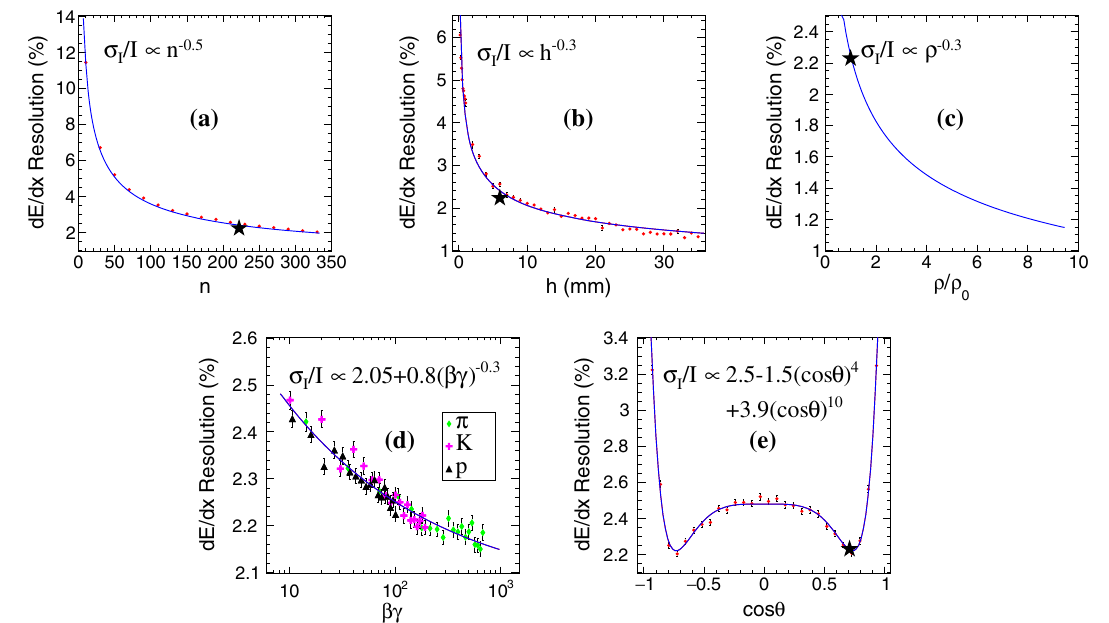
Fig. 2 The intrinsic dE / dx resolution versus the number of pad rings ing pressures) ( c ), the relativistic velocity βγ ( d ) and cos θ ( e ) of the ( a ), the pad height along the radial direction ( b ), the ratio of gas density ionizing particle. The default working point is indicated with a solid ρ over the default gas density ρ star symbol. Solid lines represent the fit 0 (equivalent to the ratio of correspond-